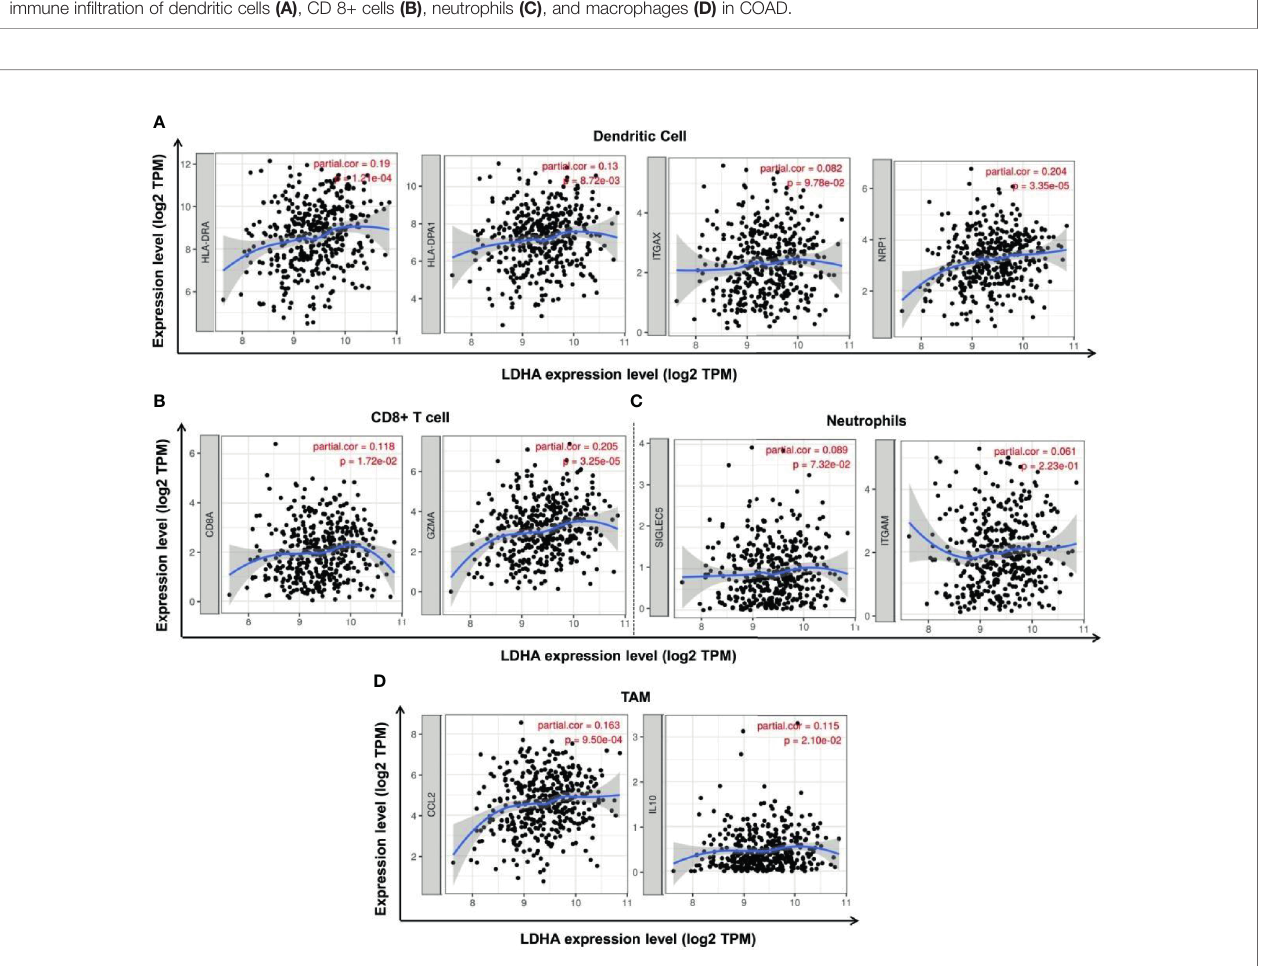
FIGURE 6 | Correlation between LDHA expression and tumor markers in COAD. (A) Correlation between LDHA expression and dendritic cell markers HLA-DRA, HLA-DPA1, ITGAX, and NRP1. (B) Correlation between LDHA expression and CD8+ T cell markers CD8A and GZMA. (C) Correlation between LDHA expression and neutrophil cell markers SIGLEC5 and ITGAM. (D) Correlation between LDHA expression and TAM markers CCL2 and